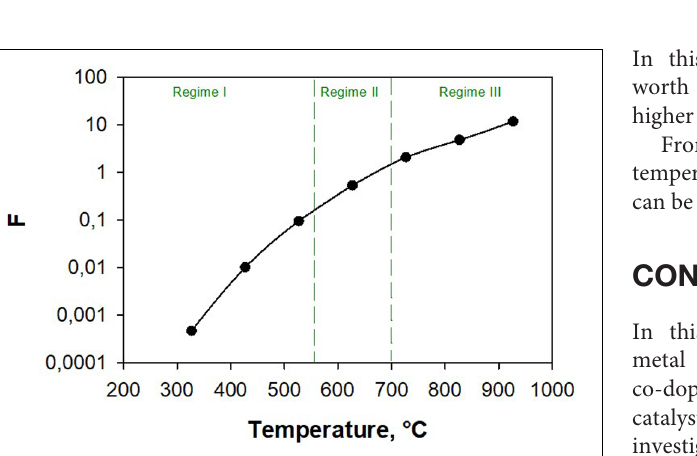
FIGURE 5 | Surface reaction rates of H 2 O and CO 2 splitting reaction (left) and their ratio R (right) as a function of decreasing reduced sites fraction on K-Fe-CeZr at different temperatures as calculated by the kinetic model.